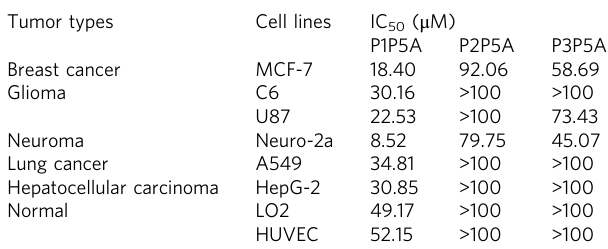
Table 1 IC 50 values of P1P5A against selected cell lines ( μ